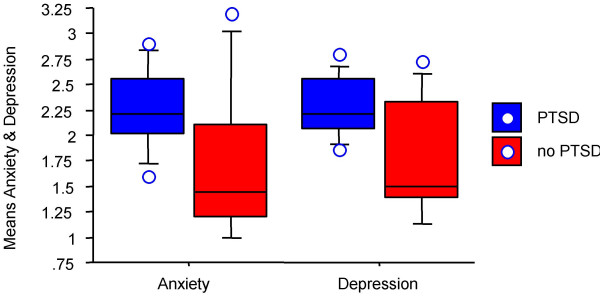
Box plot of average HSCL-25 scores of anxiety and depression in patients with (blue) and without (red) current PTSD.